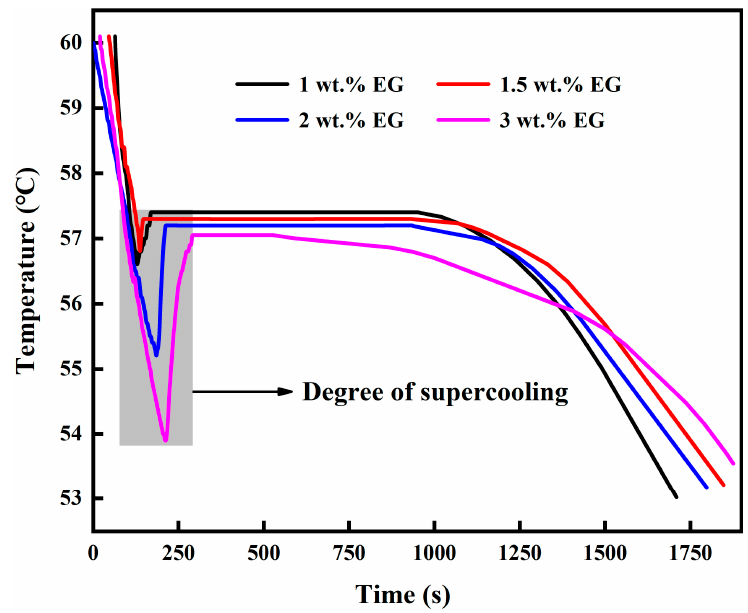
Figure 11. The influence of EG on the degree of subcooling.